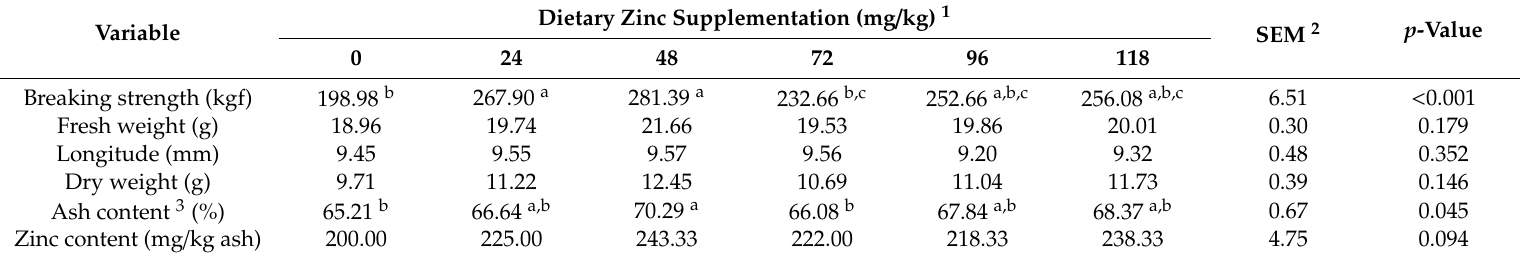
Table 5. E ff ects of dietary zinc supplementation on tibia indices of yellow-feathered broiler breeders aged 65 weeks. Variable